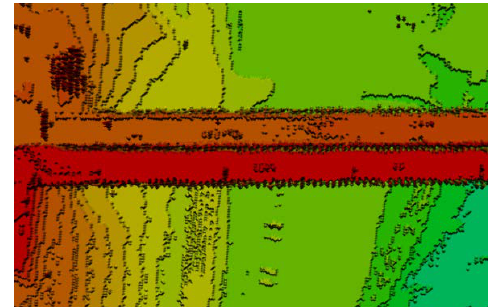
Figure 7. 50cm LIDAR DSM of the same area as figure 6